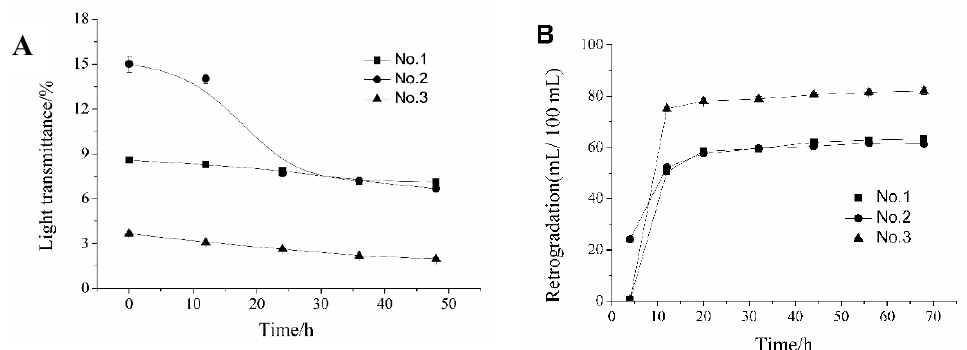
Figure 4. The light transmittance ( A ) and retrogradation ( B ) of CYYS-1, CYYS-2, and CYYS-3 during di ff erent storage times. CYYS-1, CYYS-2, and CYYS-3 represent NO. 1-, NO. 2-, and NO. 3-Chinese yam starches in Yunlong town, respectively.